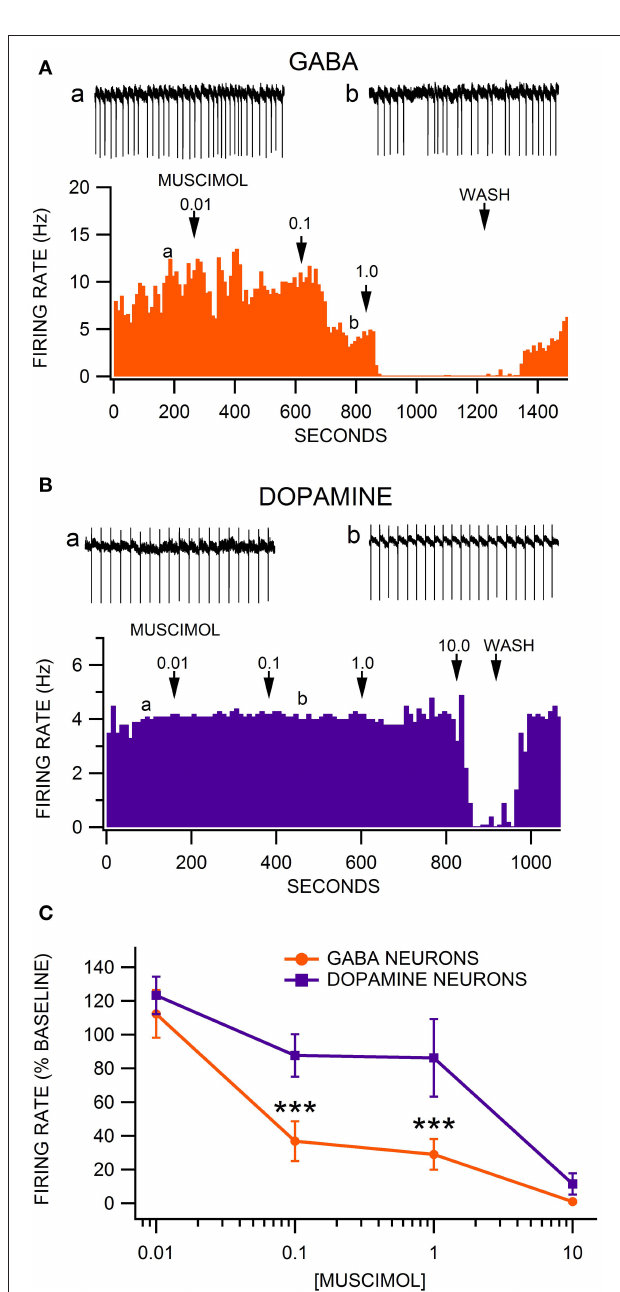
FIGURE 1 | Comparison of the sensitivity of VTA GABA vs. DA neurons to muscimol inhibition of firing rate. (A) This representative VTA GABA neuron had a baseline firing rate of ∼ 10Hz. The GABA(A)R agonist muscimol mildly inhibited the firing rate of this neuron at 0.01 µ M, moderately inhibited it at 0.1 µ M, and abolished its activity at 1.0 µ M. Insets a,b are 5s traces of GABA neuron spike activity recorded at the times indicated on the graph. (B) The ratemeter shows the activity of a representative VTA DA neuron, which had a baseline firing rate of ∼ 4Hz. Muscimol had little or no effect on this DA neuron until the firing rate was suppressed at 10.0 µ M. Insets a,b are 5s traces of DA neuron spike activity recorded at the times indicated on the graph. (C) The firing rate of VTA GABA neurons was significantly more sensitive than VTA DA neurons to muscimol at 0.1 and 1.0 µ M. Asterisks *** represent significance levels p <